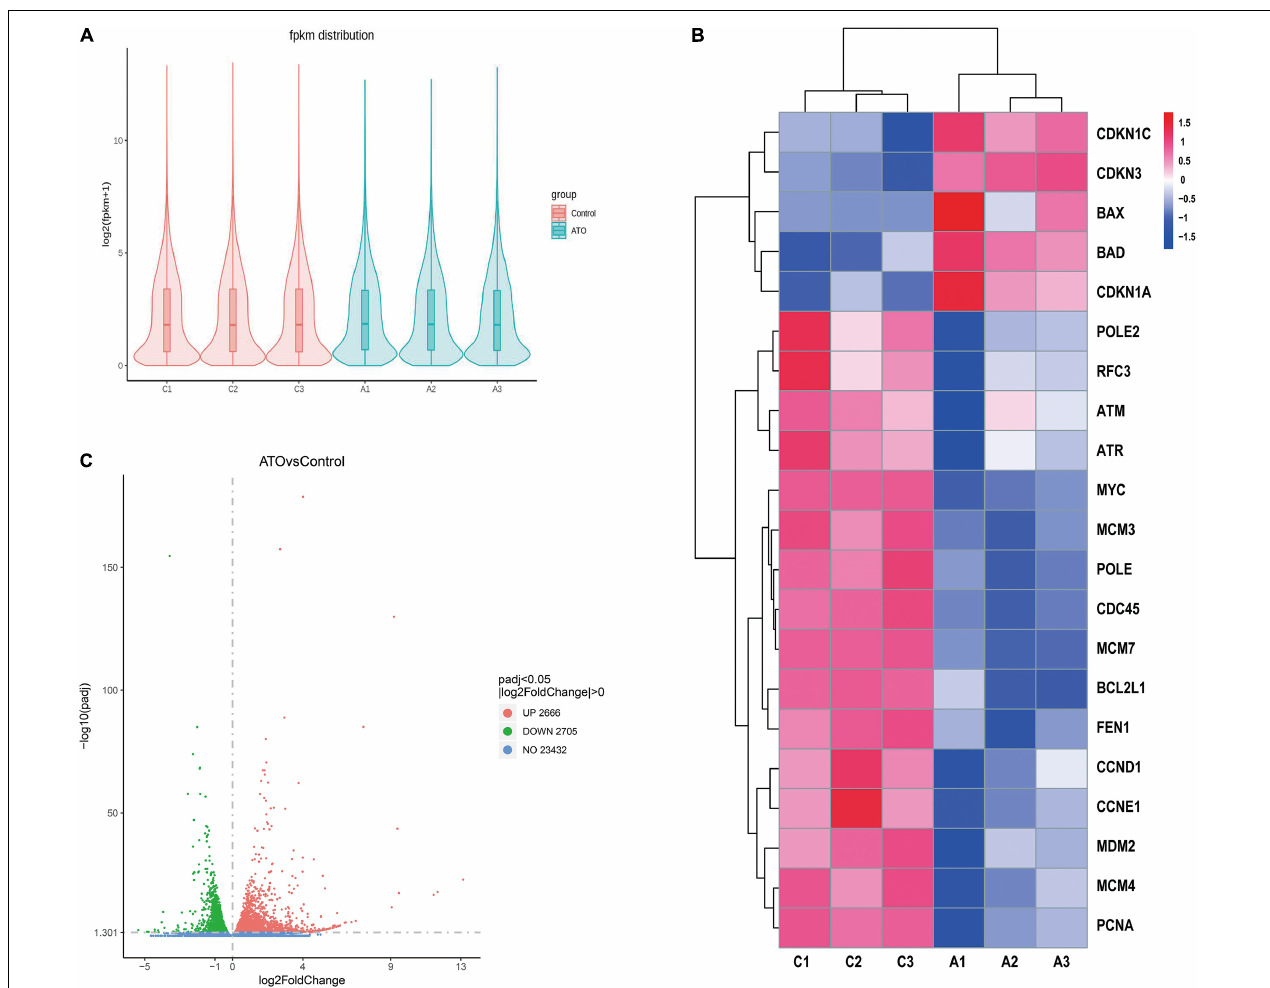
FIGURE 2 | RNA sequencing (RNA-seq) identified the differentially expressed genes (DEGs) in the control group and ATO-treated cells. (A) A violin graph displaying the comparisons of gene expression level. Each violin map corresponds to five statistics (the maximum, upper quartile, median, lower quartile, and minimum), and the width of each violin represents the number of genes. FPKM (expected number of fragments per kilobase of transcript sequence per million of base pairs sequenced) was introduced to compare the expression level of genes from different experimental conditions. (B) The FPKM hierarchical clustering map (heatmap) of the concerned DEGs. The log10(FPKM + 1) values of the DEGs were normalized to the scale numbers and clustered. Red indicates high expression genes, and blue denotes low expression genes. The color ranges from red to blue indicate the value of log10(FPKM + 1) from large to small. (C) The overall distribution of the DEGs is shown using volcanic maps. RNA-seq identified 2,666 up-regulated DEGs and 2,705 down-regulated DEGs. Up-regulated genes [log2(fold change) > 0] are shown in red, and down-regulated genes [log2(fold change) < 0] are shown in green. The DEGs were selected with a padj < 0.05 (padj, adjusted p